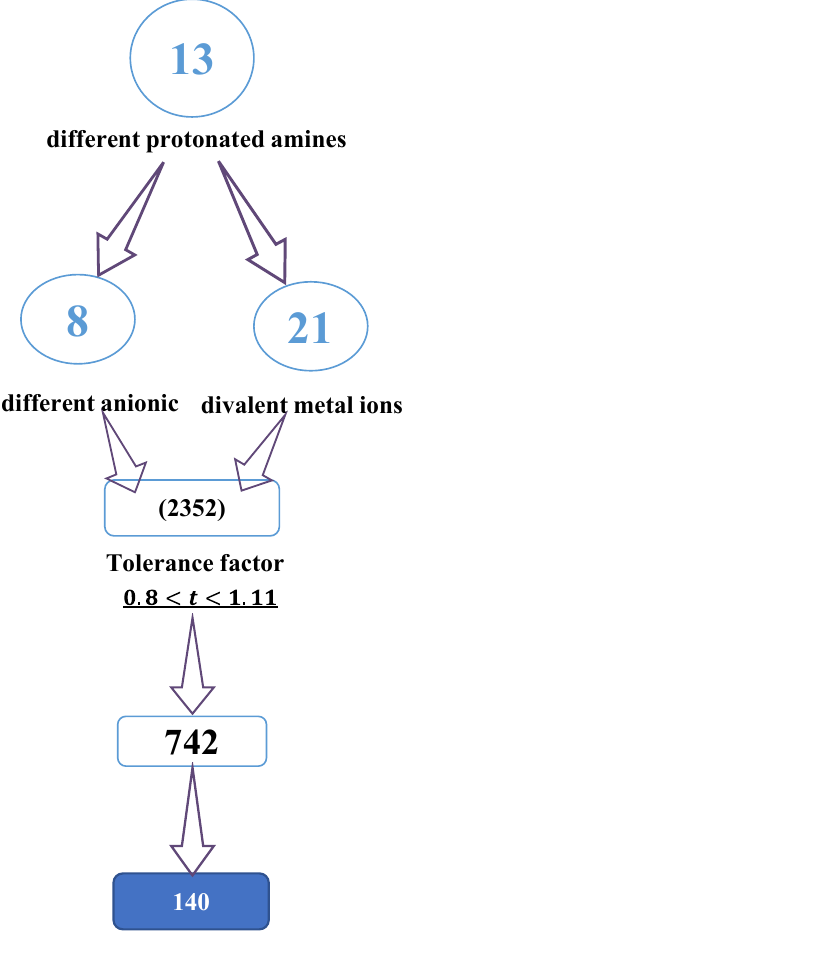
Figure 1. Diagram showing the selection process for cations using the tolerance factor.